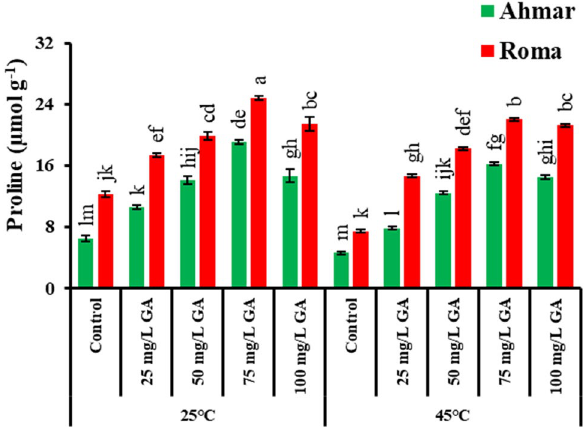
Figure 2. Proline content of tomato as affected by temperature, genotype and exogenous application of GA 3 . According to Tukey’s honestly significant difference test, the same letters suggest that there is no statistically significant difference between treatments ( p ≤ 0.05). Vertical bars indicate average ± standard error (n = 4, 5 plants per